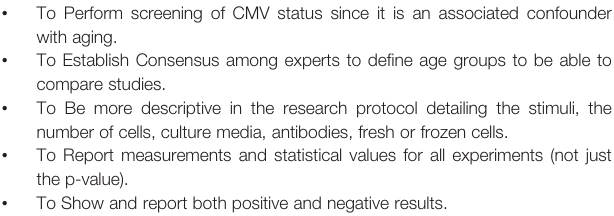
TABLE 5 | Summary: suggestions for diminishing heterogeneity in the study of